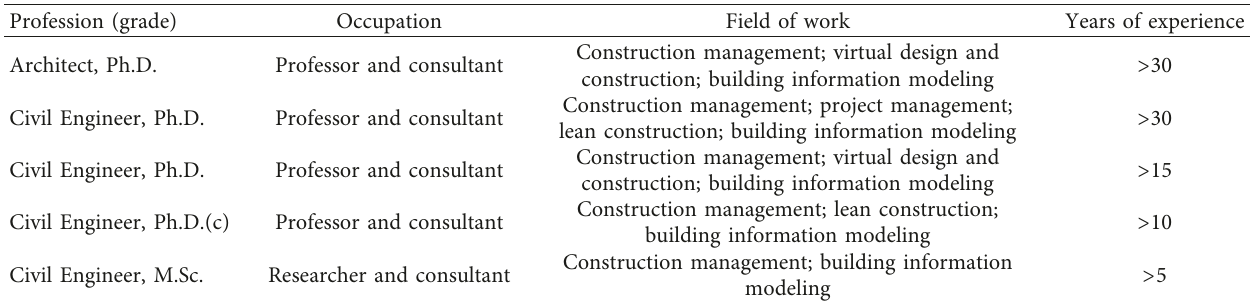
Figure 1: Research methodology. Table 1: Characterization of expert panel.